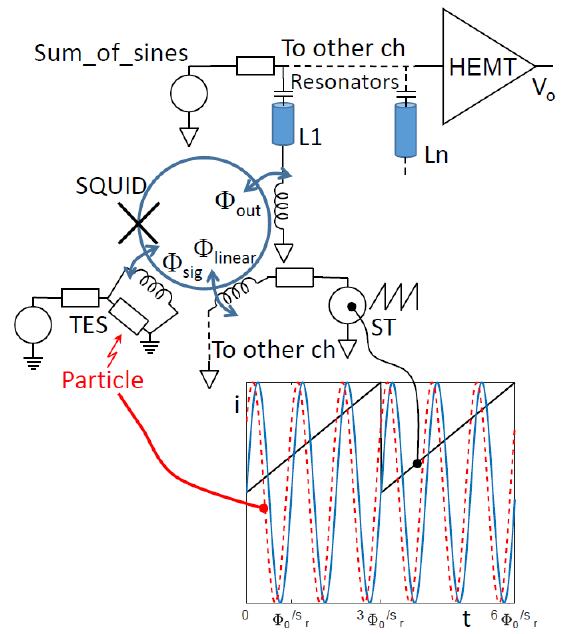
Figure 2. Simplified diagram of a rf-SQUID configured in open-loop with sawtooth flux-ramp modulation. One generator, ST, is connected in series to all the rf-SQUIDs, and one line collects all the outputs, through stubs of quarter wavelength, which each determine a tagging frequency. If the sawtooth is faster than the TES signal, the signal is seen as a phase shift of the current in the SQUID; see the diagram below, which represents Equation